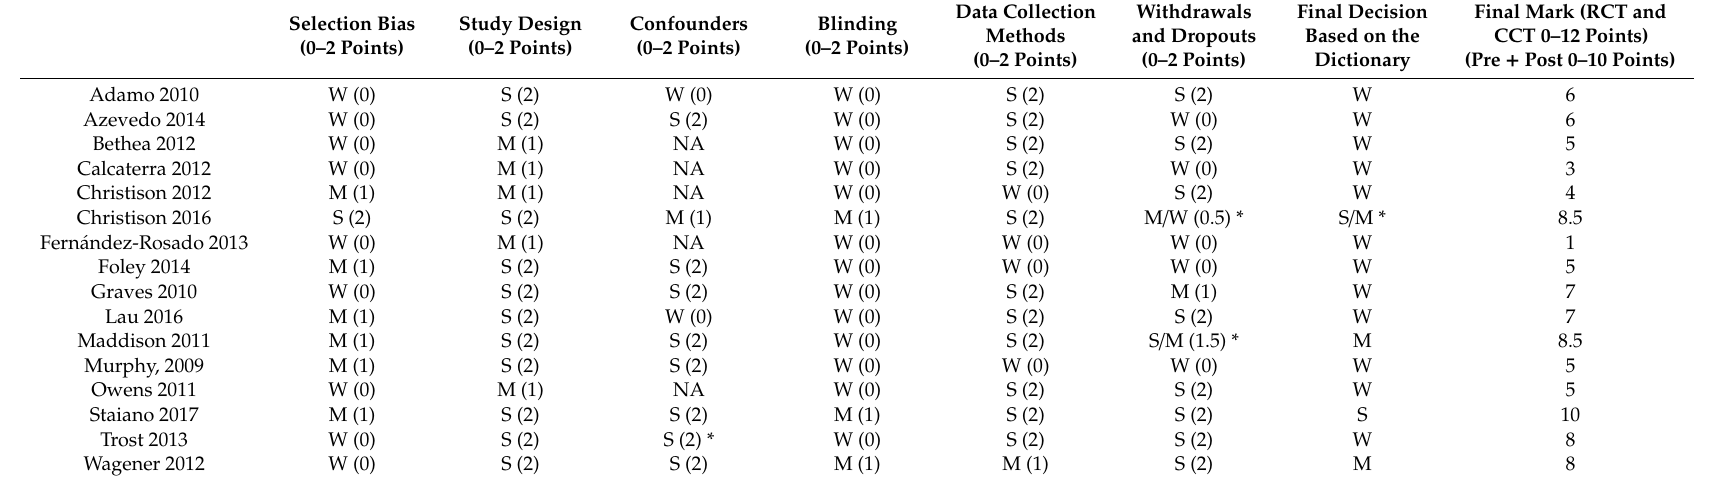
Table 3. Results of the quality assessment based on the ‘Quality Assessment Tool for Quantitative studies (EPHPP)’, for the 16 studies finally